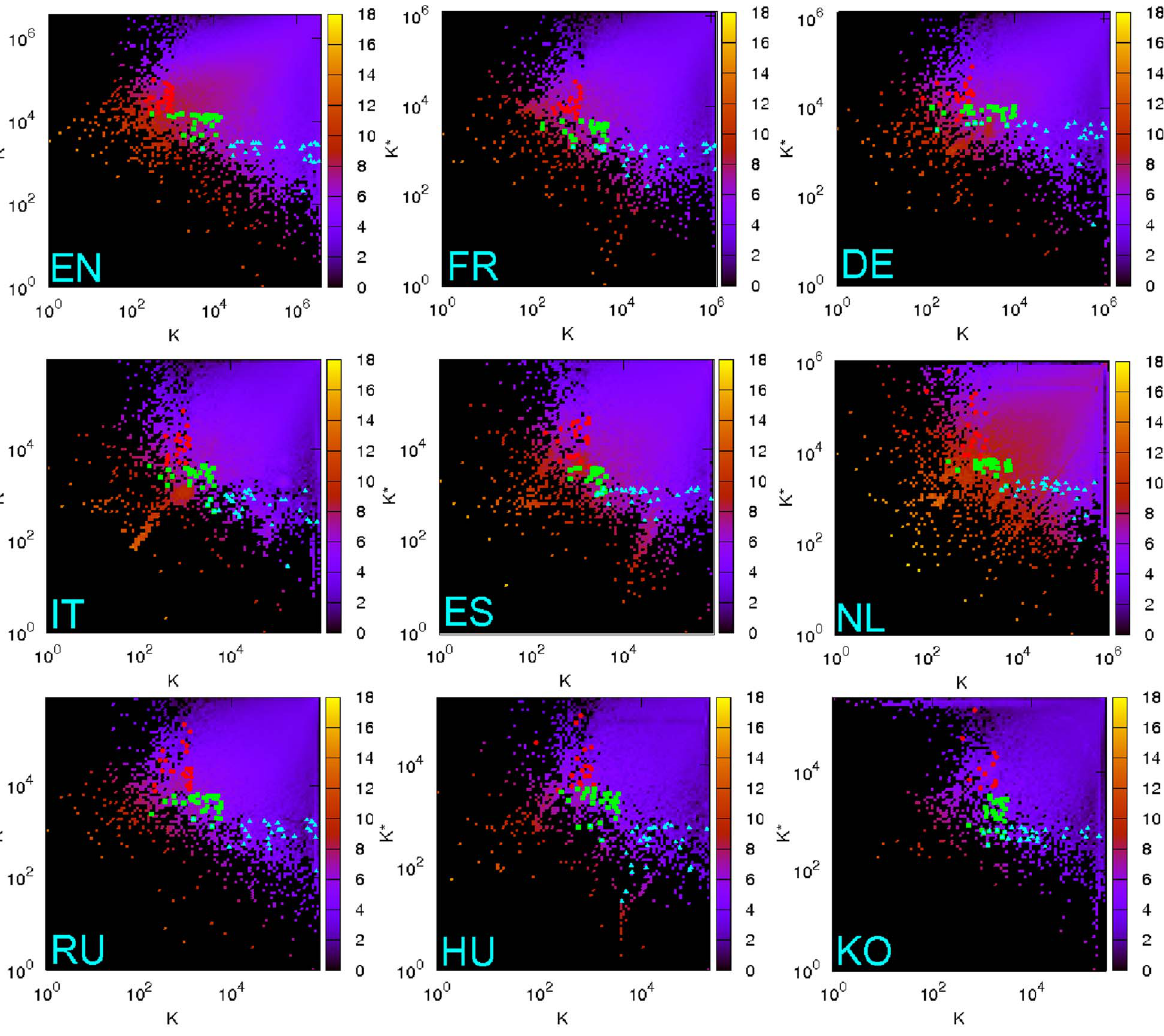
Figure 2. Density of Wikipedia articles in the PageRank ranking K versus CheiRank ranking K (cid:2) plane for each Wikipedia edition. The red points are top PageRank articles of persons, the green points are top 2DRank articles of persons and the cyan points are top CheiRank articles of persons. Panels show: English (top-left), French (top-center), German (top-right), Italian (middle-left), Spanish (middle-center), Dutch (middle-left), Russian (bottom-left), Hungarian (bottom-center), Korean (bottom-right). Color bars shown natural logarithm of density, changing from minimal nonzero density (dark) to maximal one (white), zero density is shown by black.